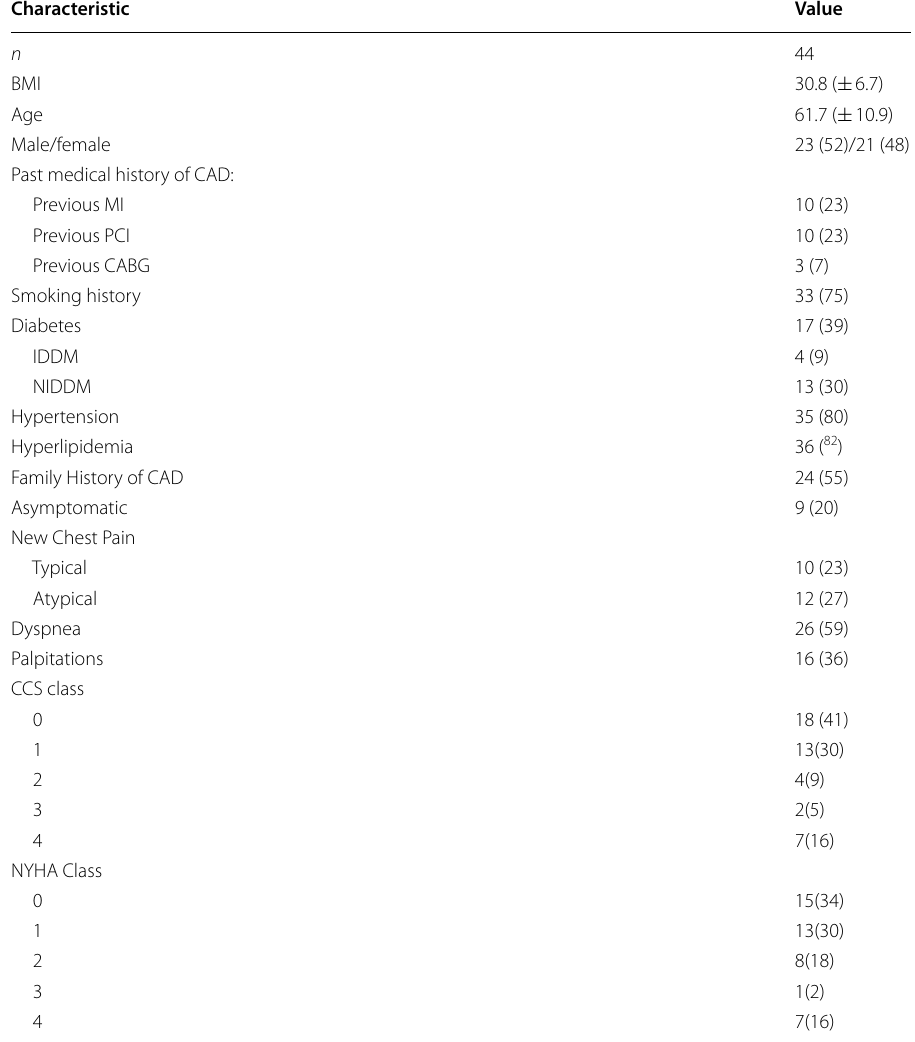
Table 1 Patients